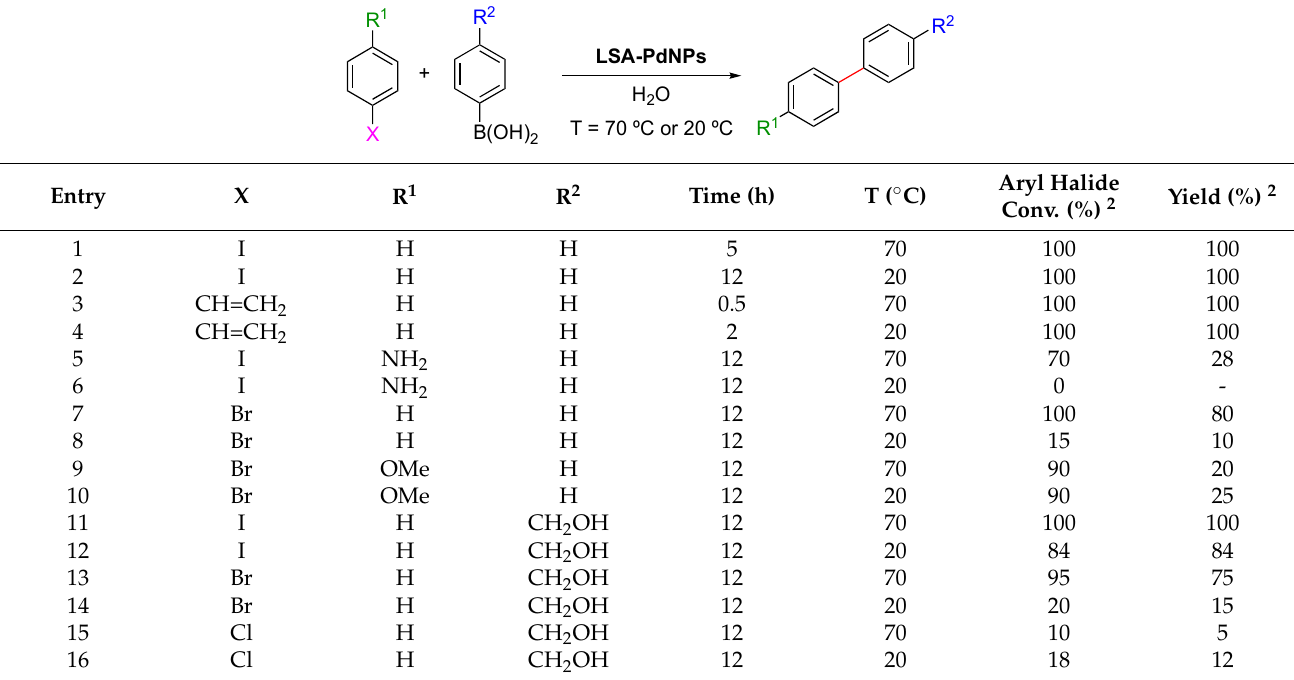
Table 7. LSA-PdNPs catalyzed the Suzuki–Miyaura cross-coupling reaction between aryl halides and phenyl boronic acids [71] 1 .